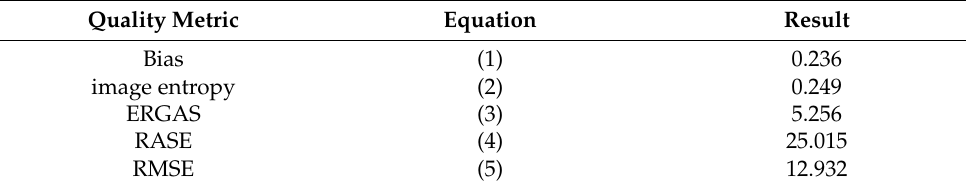
Table 1. Quality metrics